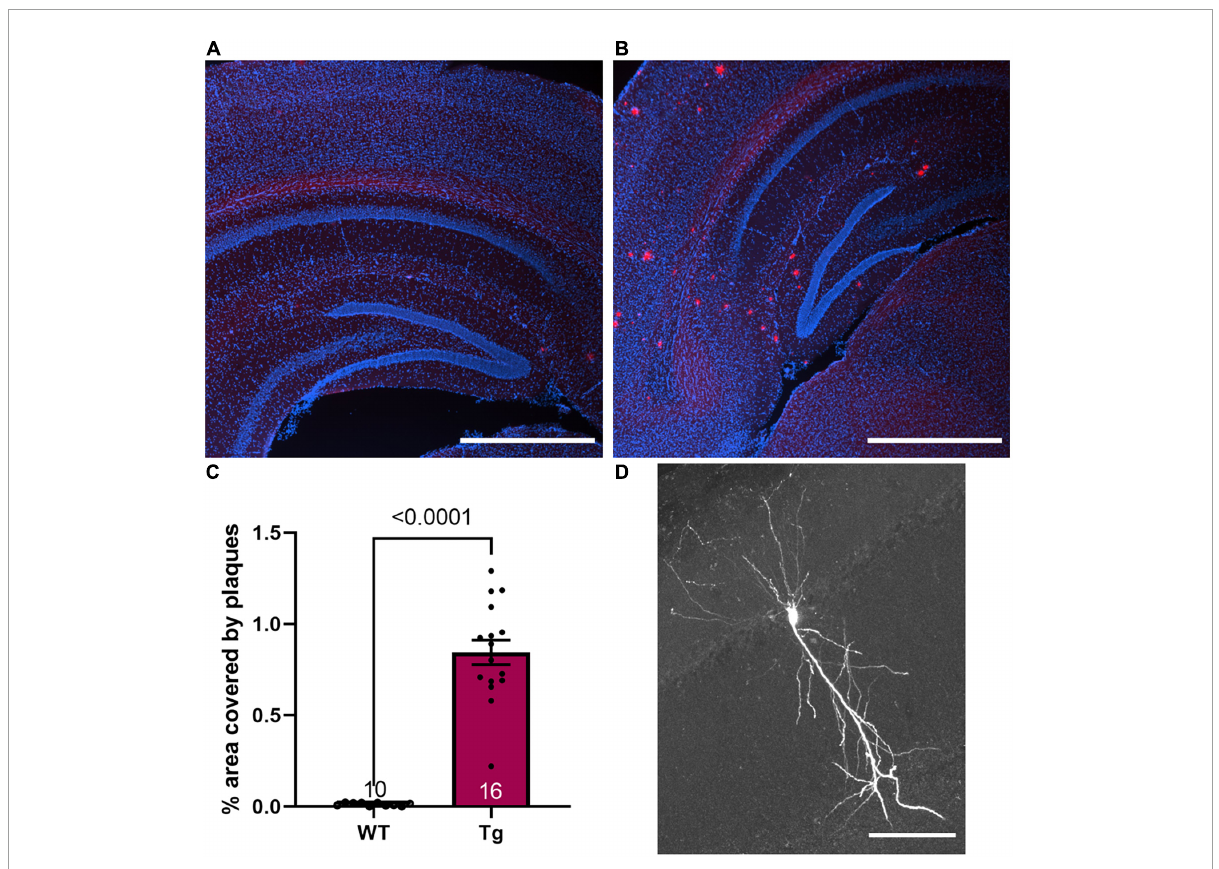
FIGURE1 Plaque phenotype is present in 8-month-old Tg mice. (A,B) Fluorescence image of nuclei (DAPI, blue) and Congo red stain (red) merged in (A) a WT mouse and (B) a Tg mouse. Scale bar 1 mm. (C) The average plaque area in the hippocampus was 0.85 ± 0.07% in 8-month-old Tg mice ( n = 16) while the background fluorescence in the WT animals results in an area of 0.01 ± 0.003% ( n = 10). (D) A representative CA1 neuron filled with biotin during whole-cell patch clamp recordings. Scale bar 100 µ